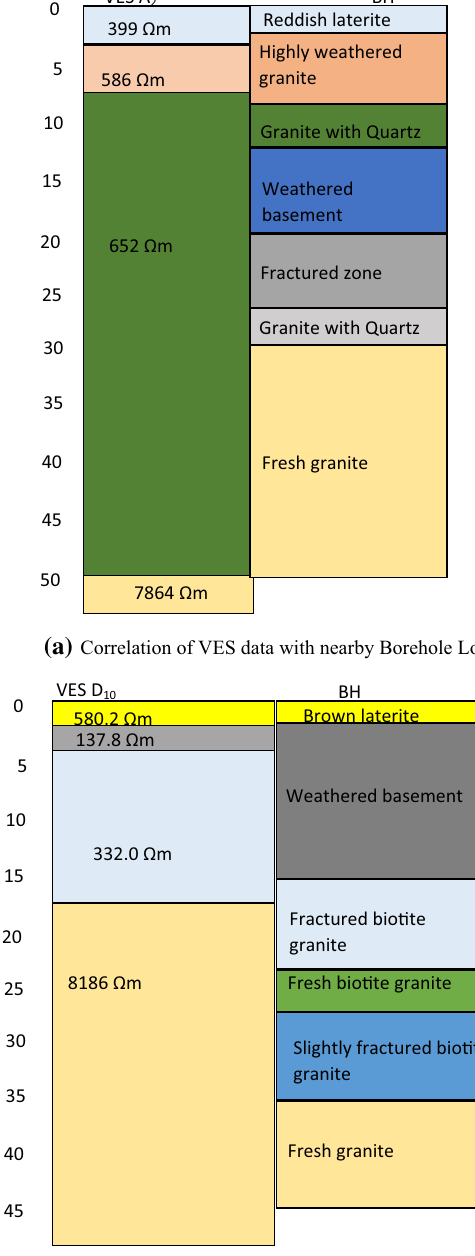
(b) Correlation of VES data with nearby Borehole Log Fig. 11 a , b Correlation of VES data with nearby borehole log